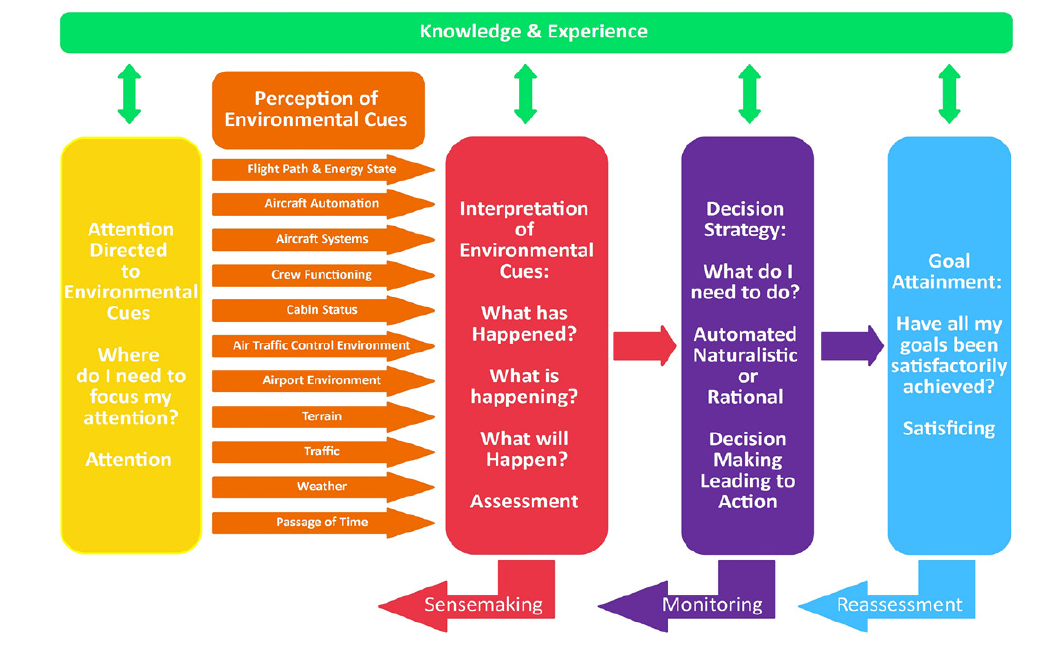
Figure 1. Proposed model of pilot situation awareness. Adapted with permission from Irwin